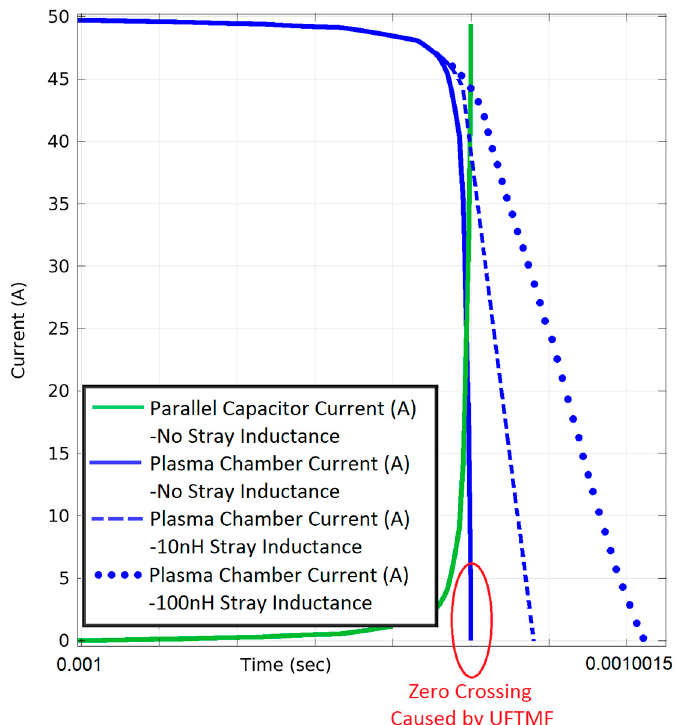
Figure 6. Waveforms of the plasma chamber and parallel capacitor current after application of an UFTMF of 1 T. Successful commutation is achieved with the 200 nF parallel capacitor.